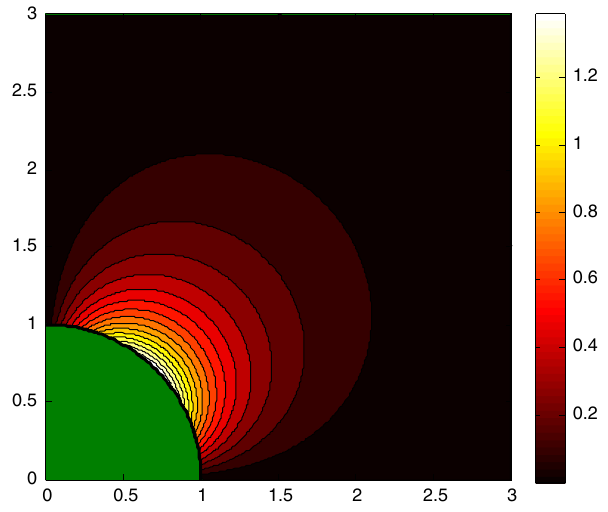
FIG. 10. Transverse field F ρ for a boss normalized with respect to the background field F . On the surface of the boss, o 3 sin θ cos θ . The boss is the green hemisphere in the F ρ =F o ¼ lower